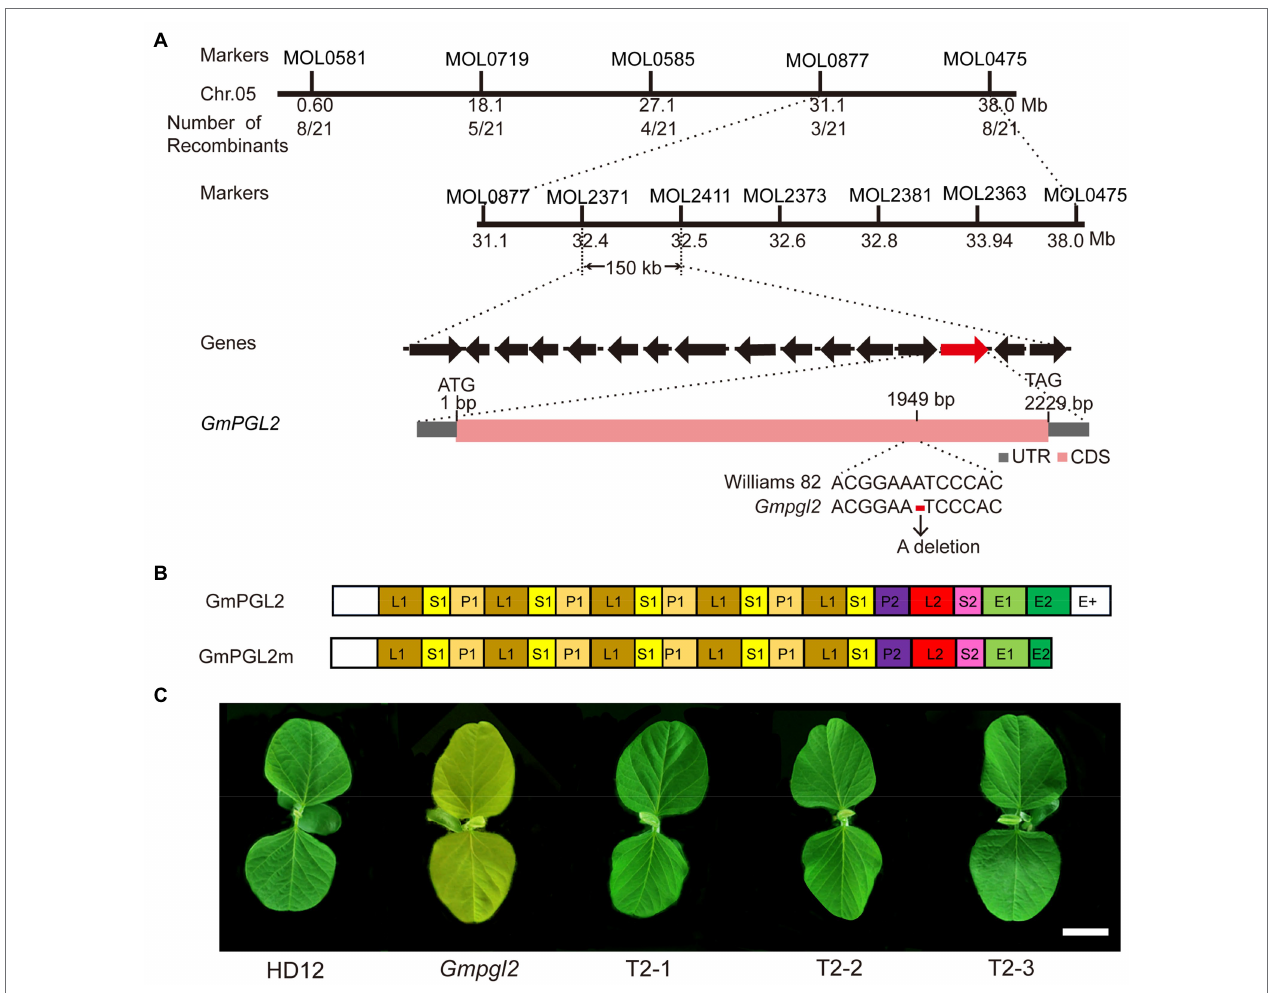
FIGURE 2 | Map-based cloning of the GmPGL2 gene. (A) Map-based cloning of the GmPGL2 allele. (i) The GmPGL2 mutation was narrowed to a 150-kb region between the InDel markers MOL2371 and MOL2411 on chromosome 5. (ii) The black arrows represent the 15 putative genes in this 150-kb genomic region; the candidate gene GmPGL2 ( Glyma.05g132700 ) is indicated with the red arrow. (iii) Schematic diagram of the Glyma.05g132700 gene. ATG and TAG, the start and stop codons, respectively, are shown. A deletion point mutation at the 1949 bp nucleotide position is shown. (B) Schematic diagram of the GmPGL2 protein. The GmPGL2 gene encodes a PPR protein of the PLS-type carrying a E+ domain. The GmPGL2 protein has 17 PPR motifs; P, L, and S represent the PPR motifs of various repeat lengths; E+ is a domain required for RNA editing. (C) Complementation of the Gmpgl2 mutant. Phenotypes of HD12, GmPGL2 , and a 35S: GmPGL2 complemented Gmpgl2 plant. Scale bars = 3